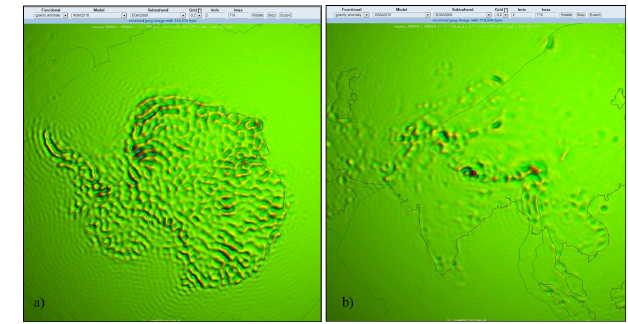
Figure 14. Examples of the visualization service for the gravity anomaly differences computed from XGM2016 and EGM2018 up to a degree and order of 719 for the (a) Antarctica and (b) Hi- malaya regions. The EGM2008 relied exclusively on ITG-Grace03s (Mayer-Gürr, 2007) expanded up to d/o 120 to fill Antarctica with synthetic values, whereas, in XGM2016 (Pail et al., 2018), these synthetic values were derived from GOCO05s (Mayer-Gürr et al., 2015) and from forward modelling of ice and rock thicknesses from the Earth2014 digital terrain model (Hirt and Rexer,